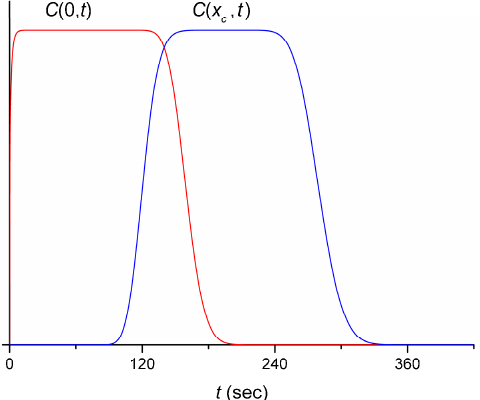
Figure 4. Diffusional spreading of the initially approximately rectangular pulse (arbitrary units) of 170 s duration (red curve), calculated from Equation (1). Here the velocity of the flow was taken as 0.1 cm/s , which is comparable to the experimental value, and we used a representative value (cid:1830) = 7 × 10 (cid:2879)(cid:2874) cm (cid:2870) /s . The blue curve represents the time-dependence of the pulse at the end of the channel, taken 12 cm